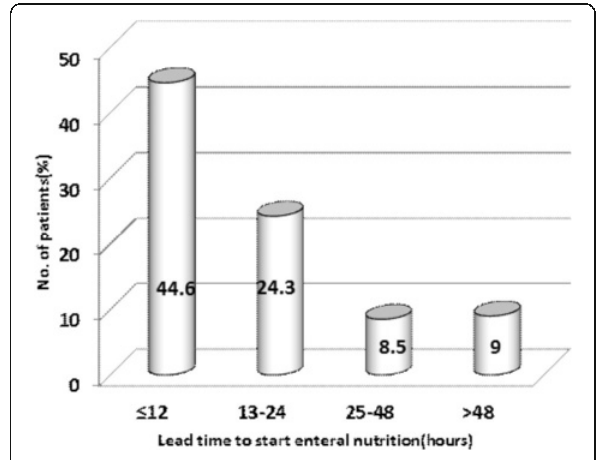
Fig. 27 (abstract A55). Lead time to initiate feeding(hours)